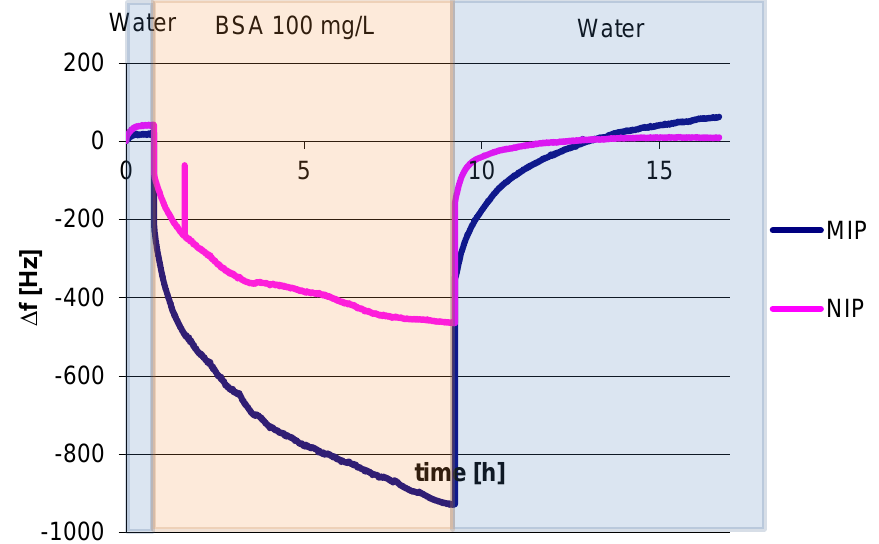
Figure 3. Quartz micro balance (QCM) sensor responses of 100 mg/L albumin.